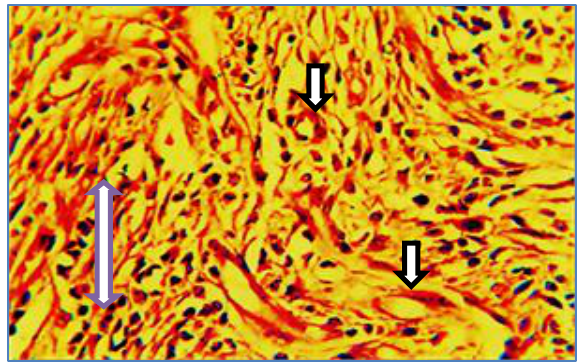
Figure, 9: In first group, 4 months post-suturing shows few blood vessels (short arrows) thickened collagen fibers with mononuclear cells infiltration in cut tendon fibers (long arrow) (H &E stain; 10X).